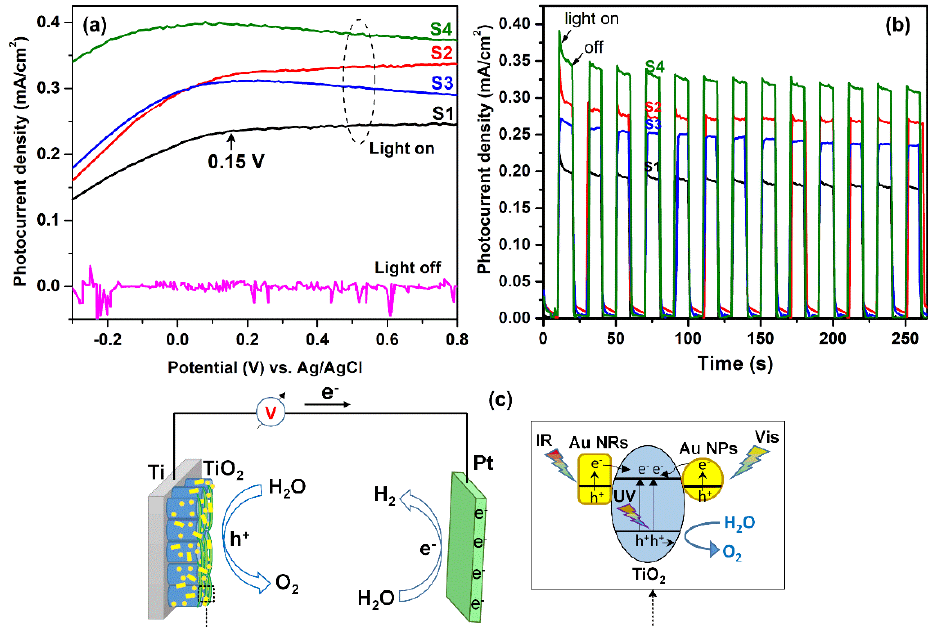
Figure 7. ( a ) Linear sweep voltammetry (LSV) of TNWs/TNAs and Au-TNWs/TNAs (S 1 – S 4 ) recorded in a 0.5 M Na 2 SO 4 solution under the illumination of 100 W xenon lamb. ( b ) Chronoamperometric I−t curves for the samples collected at 0.15 V versus RHE under the UV-Vis irradiation of 100 W xenon lamp. ( c ) A schematic illustration for PEC water splitting using Au NPs-NRs-TNWs/TNAs array as a photoanode.